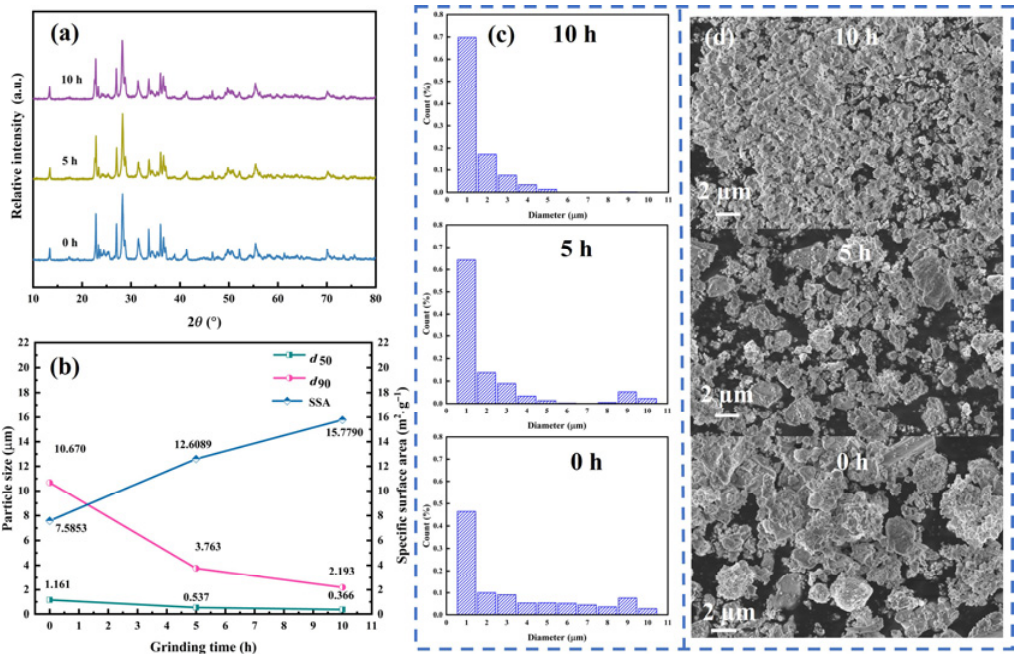
Fig. 1 (a) XRD patterns; (b, c) d 50 and d 90 , SSAs, and particle size distributions. (d) SEM images of raw material mixtures unground and ground for different time (i.e., 5 and 10